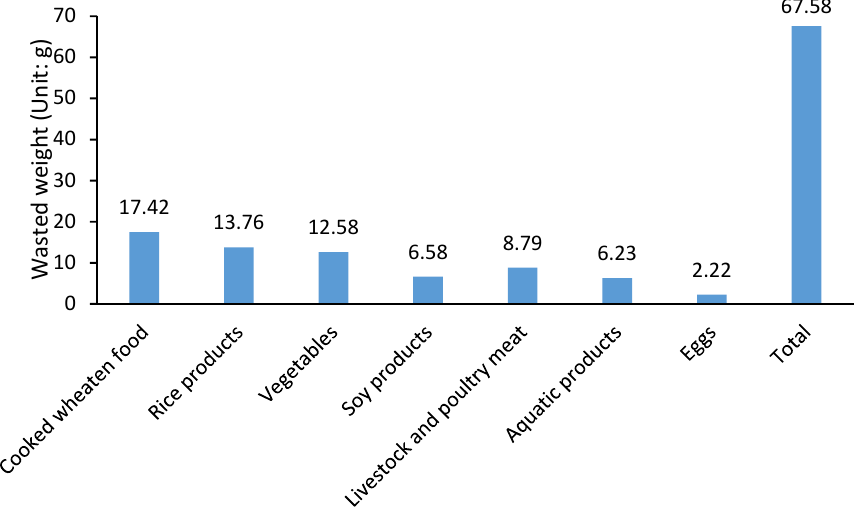
Figure 1. Total food waste per student per meal and its composition.